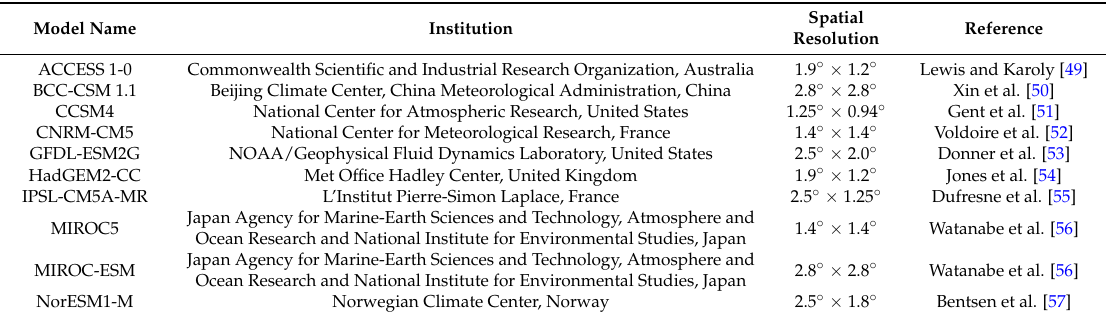
Table 2. Description of CMIP5 models used in this